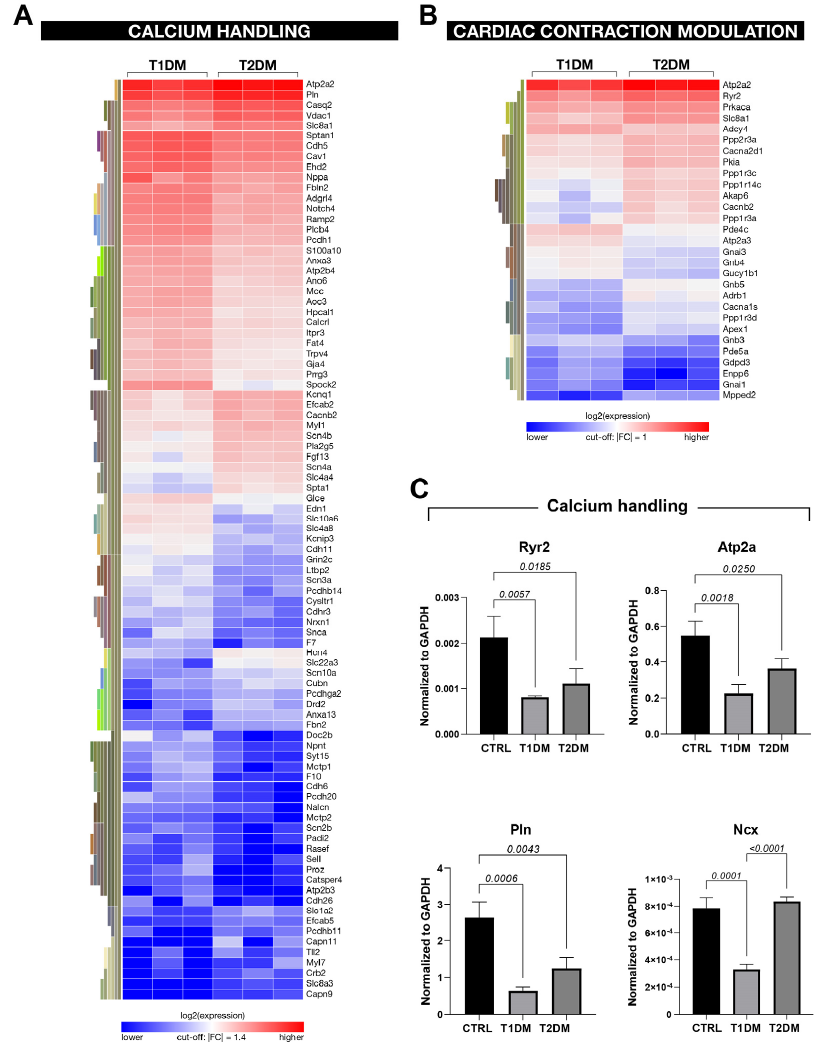
Figure 7. RNA-seq analysis from STZ-based T1DM and T2DM mouse models displayed modulation in the genes involved in calcium handling. ( A , B ) Heat maps showing differently expressed genes involved in the Ca2+ handling and cardiac contraction modulation processes in T1DM vs. T2DM. ( C ) Bar graphs showing the expressions of selected genes involved in Ca 2+ handling in CMs isolated from CTRL, T1DM and T2DM mice (n = 3). Data are mean ±